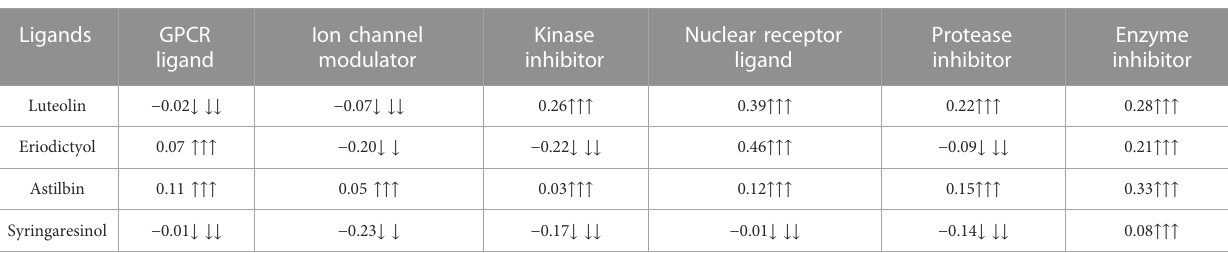
TABLE 4 Prediction of bioactivity of ligands by